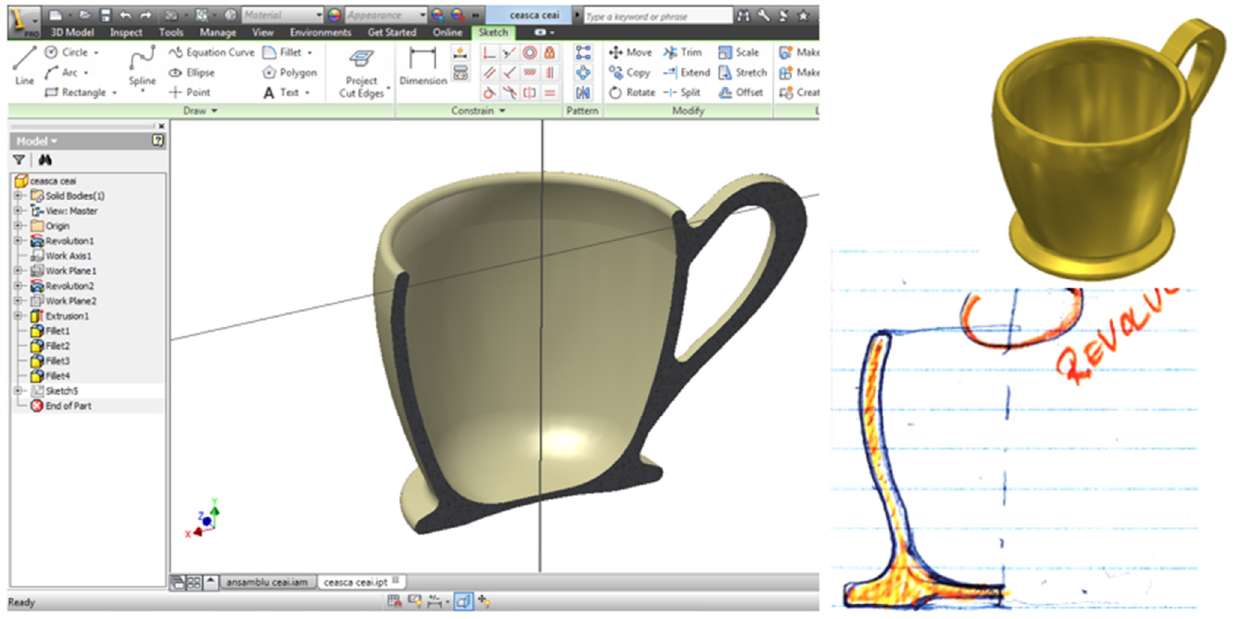
Figure 7. Generating 3D modeling in the Inventor environment.